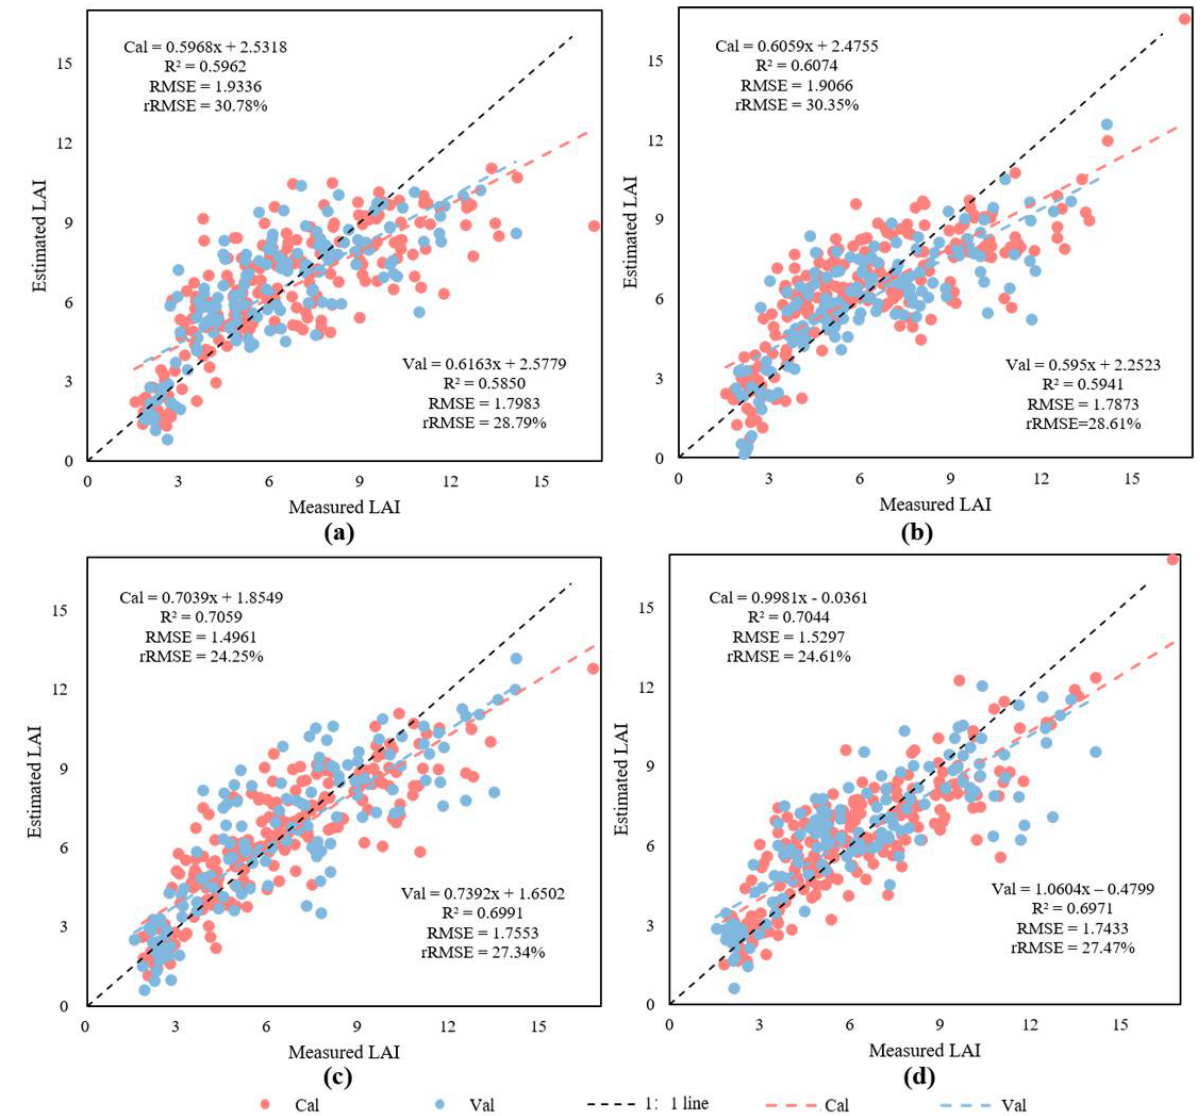
Figure 8. Linear results of measured and predicted values based on spectral reflectance model training sets (Cal) and validation sets (Val): ( a ) MSR-SNV-SPA, ( b ) MSR-SNV-SFLA, ( c ) ELM-SNV-SPA, and ( d ) ELM-SNV-SFLA.